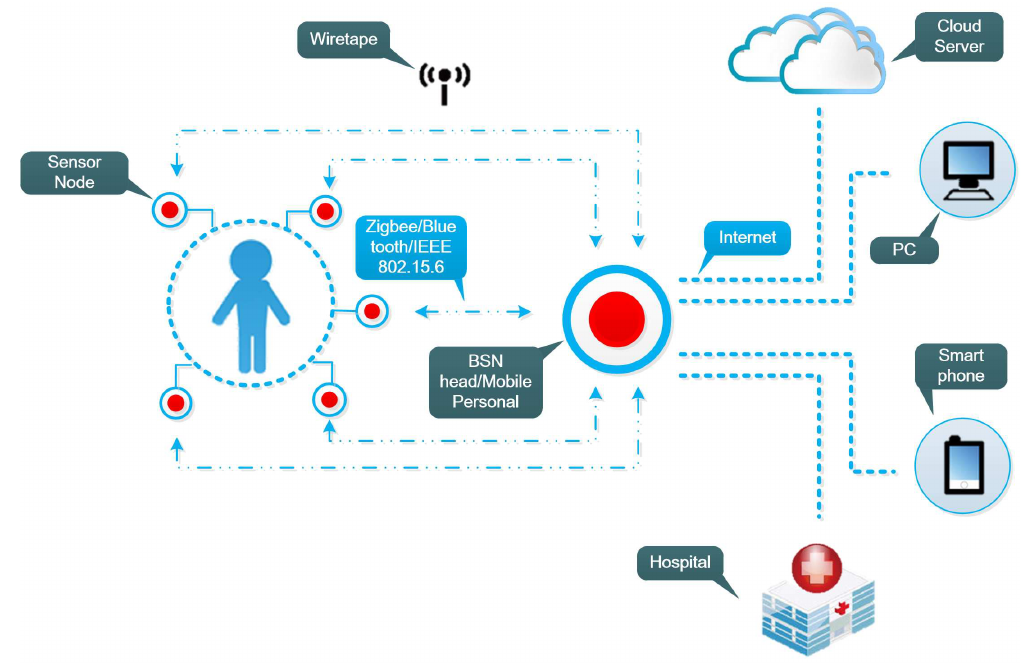
Figure 1. WBAN Network